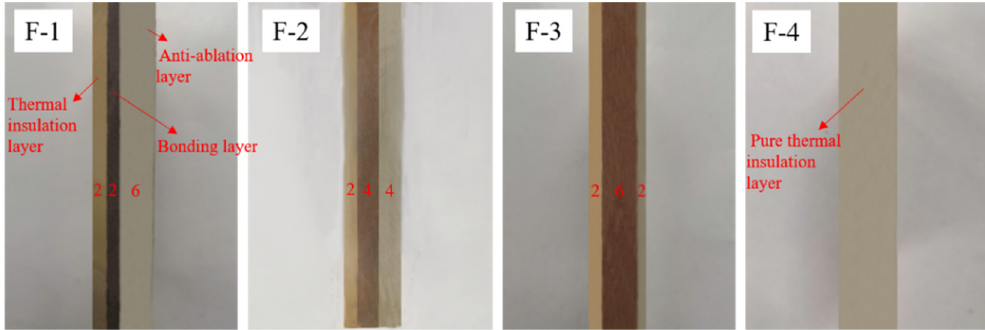
Figure 2: Physical diagram of composites.